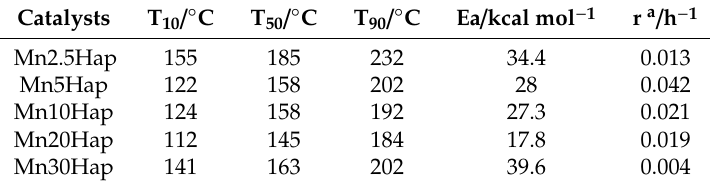
Figure 5. Conversion of HCHO into CO 2 over MnxHap catalysts. Table 3. Catalytic performances of the MnxHap